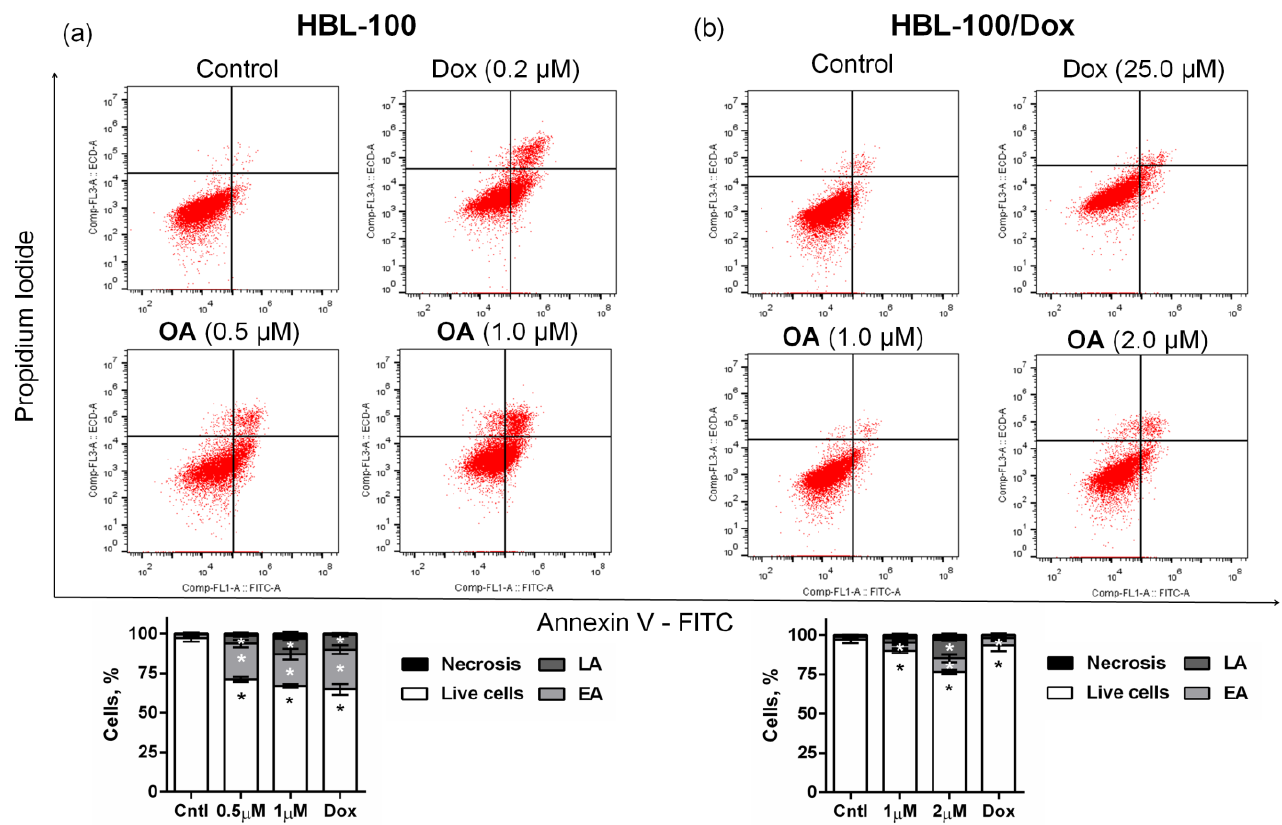
Figure 6. Annexin V-FITC/PI double staining for detection of apoptosis after treatment with OA for 16 h: ( a ) HBL-100; ( b ) HBL-100/Dox cells. LA — late apoptosis; EA — early apoptosis. * Statistical significance of number of cells as compared to control value ( p < 0.05).